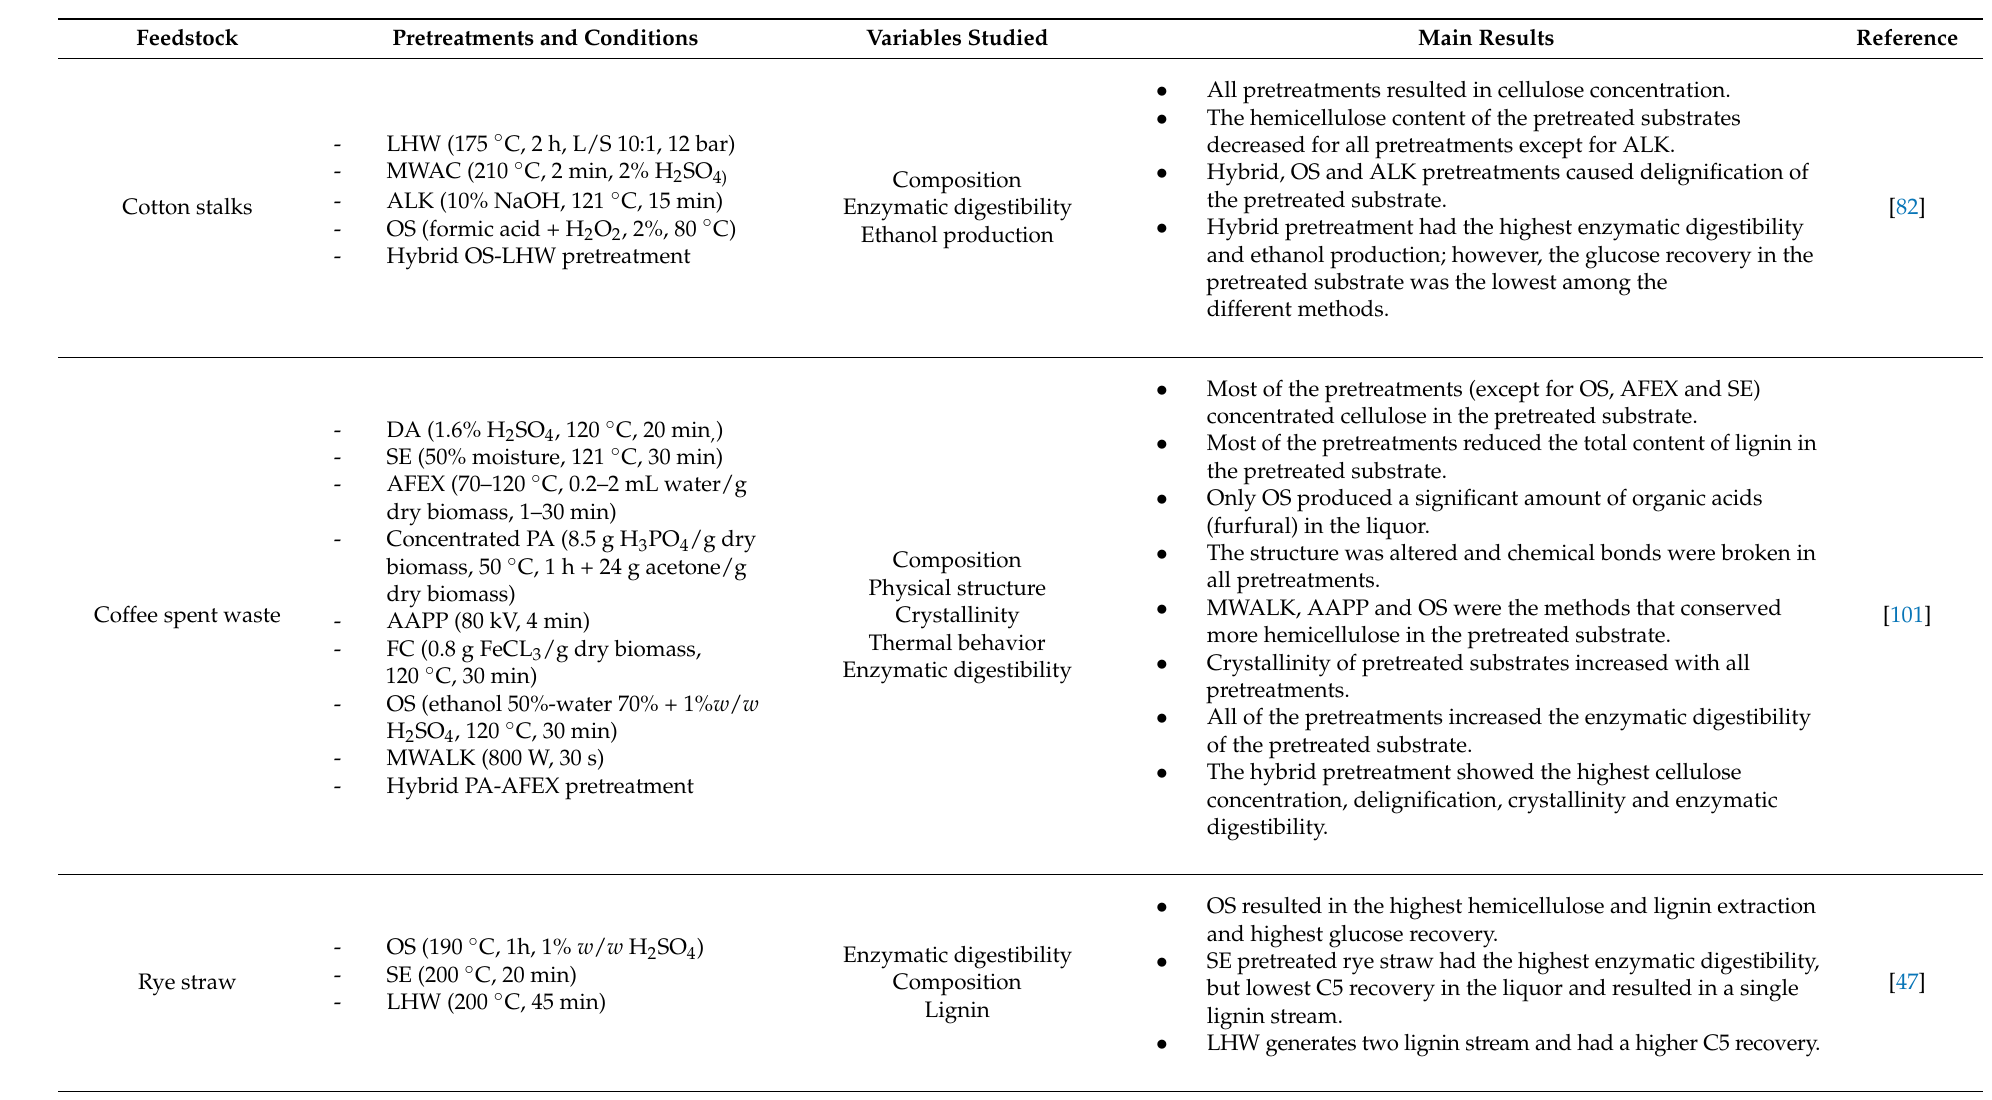
Table 3. Compilation of comparisons among different pretreatment